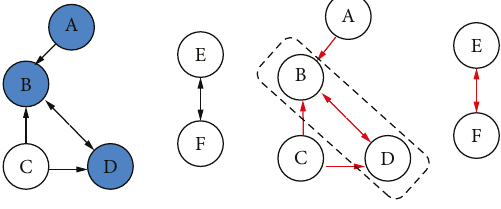
Figure 4: Typical DRG among various